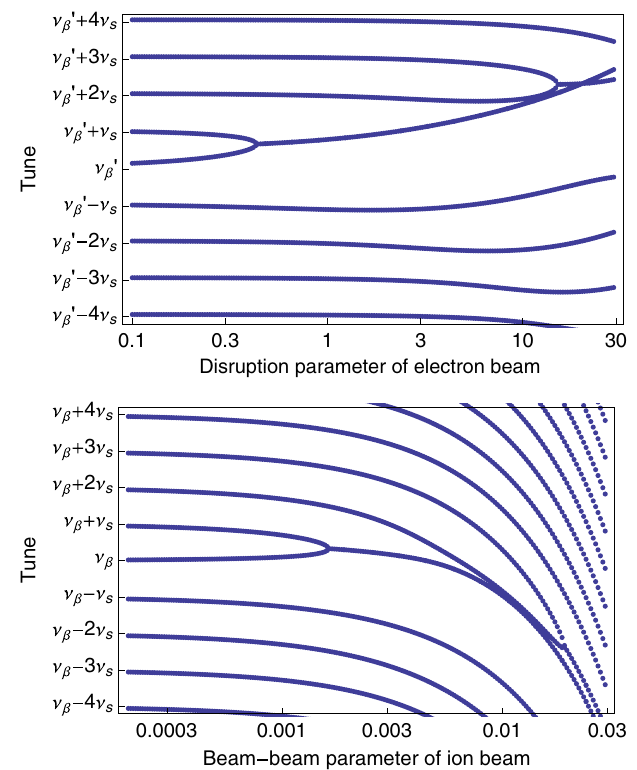
FIG. 2. Frequency contents of the matrix M t as a function of the disruption parameter of the electron bunch with (cid:6) i ¼ 0 : 015 (top) and the beam-beam parameter of the ion bunch with d e ¼ (cid:10) 10 (bottom). In the vertical axis, (cid:10) (cid:1) and s denote the betatron and synchrotron tunes respectively, (cid:10) 0 (cid:1) ¼ (cid:10) (cid:1) (cid:1) (cid:6) i is the betatron tune including the beam-beam tune shift.